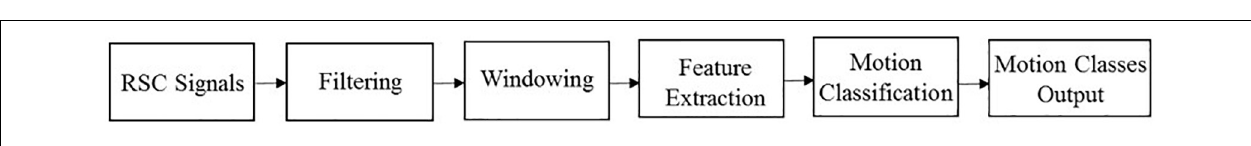
FIGURE 3 | Procedure of RSC-based motion pattern